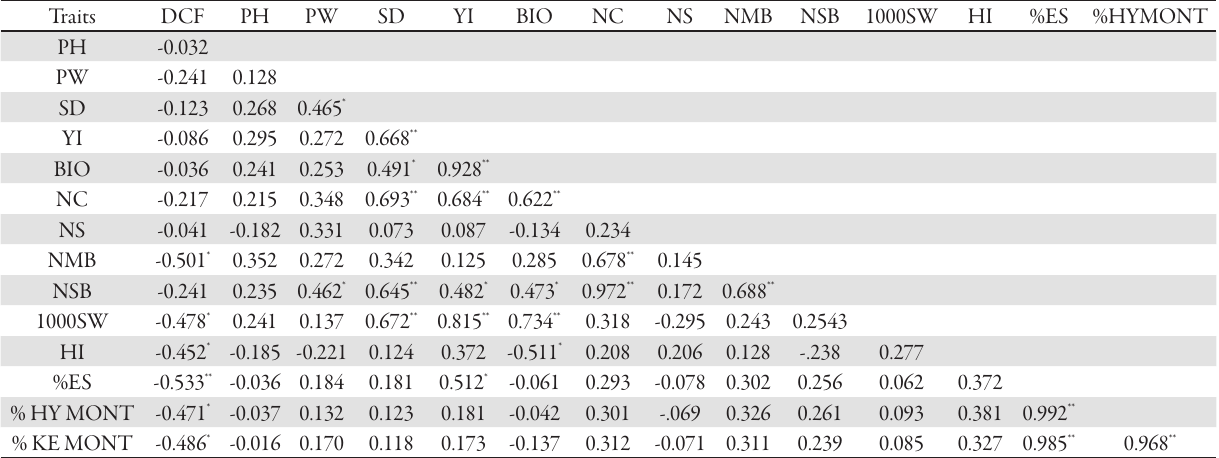
Tab. 3. Simple correlation coefficients of black seed characters under water deficiency conditions